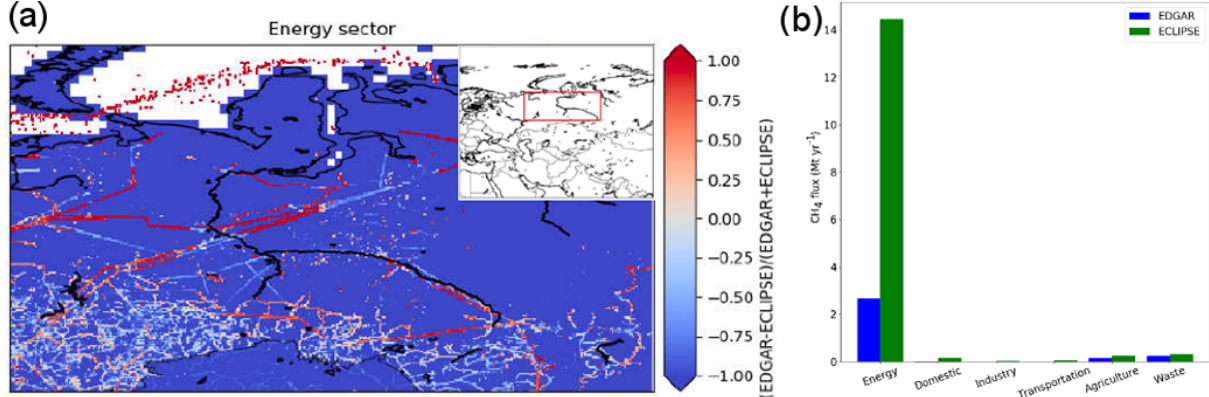
Figure 26. Comparison of the EDGAR v4.3.2 and ECLIPSE v5a inventories for methane. (a) Spatial-distribution-normalized difference (b) total by sector of methane emissions for the western Siberia